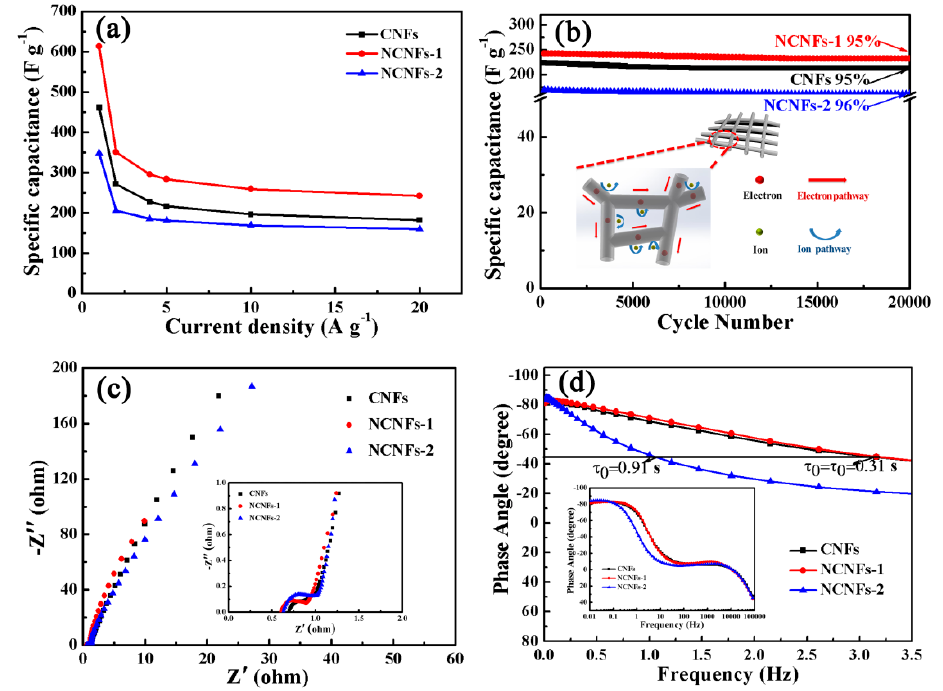
Figure 7. ( a ) The specific capacitance calculated by galvanostatic charge-discharge curves at different current densities ranging from 1 A g − 1 to 20 A g − 1 , ( b ) cycling stability at 10 A g − 1 for N CNFs-1, CNFs and N CNFs-2 (the inset in ( b ) shows the schematic illustration for electron and ion pathway of the 3D hierarchical nitrogen doped carbon nanonet flakes). ( c ) Nyquist plots. (Z’: real impedance, Z”: imaginary impedance. And the inset shows a partial enlarged view in high frequency range). ( d ) Bode plots of phase angle relate to frequency in the low frequency range (the inset shows the normal bode plot).